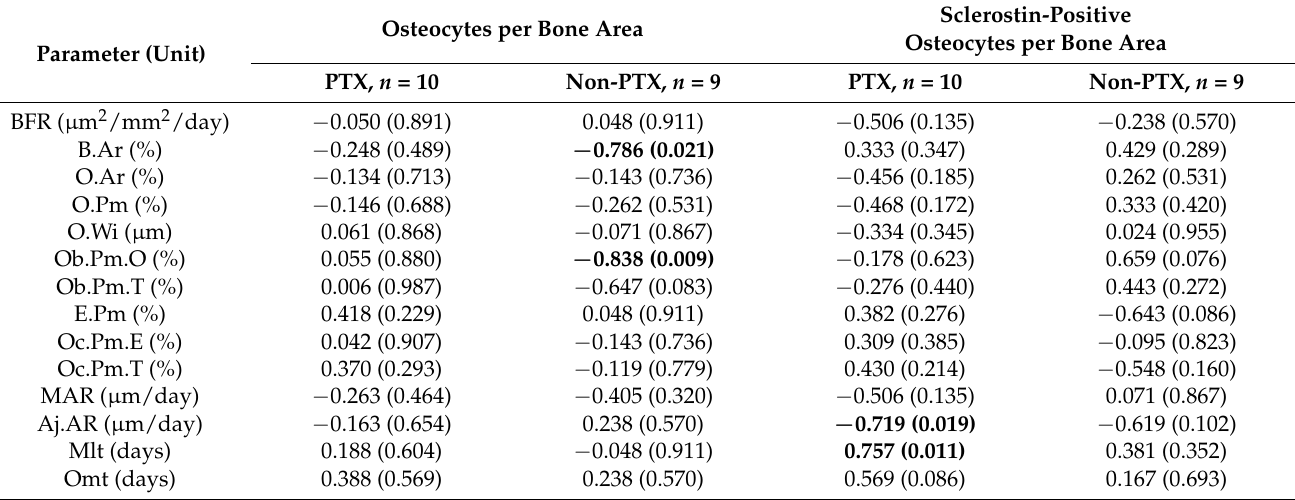
Table 1. Correlations between bone histomorphometric parameters in trabecular bone and cell counts.